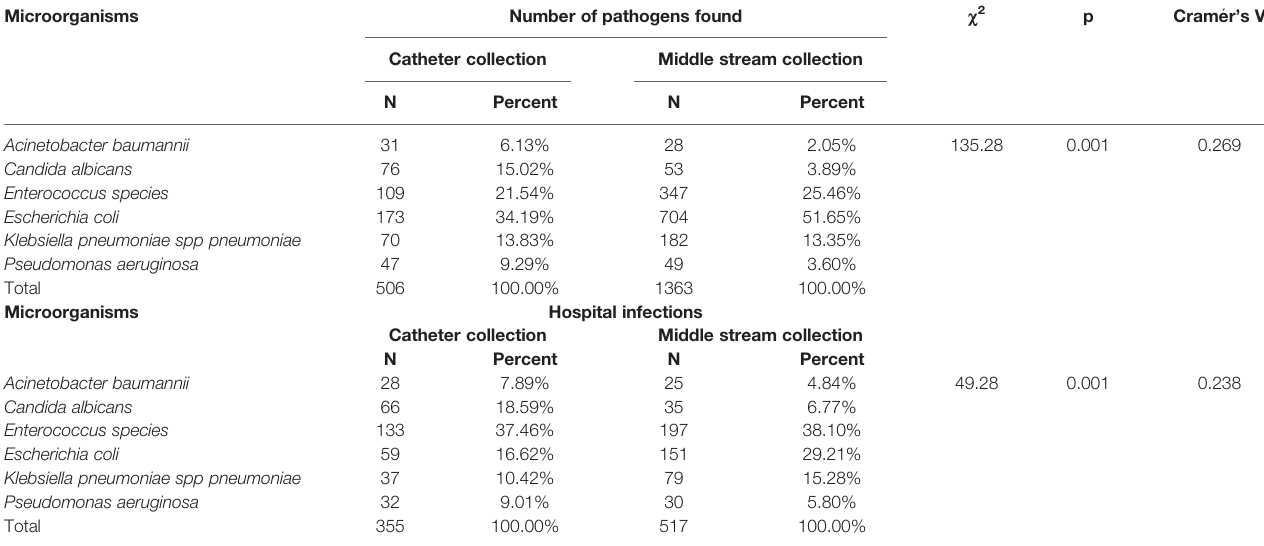
TABLE 4 | Presence of the most important types of